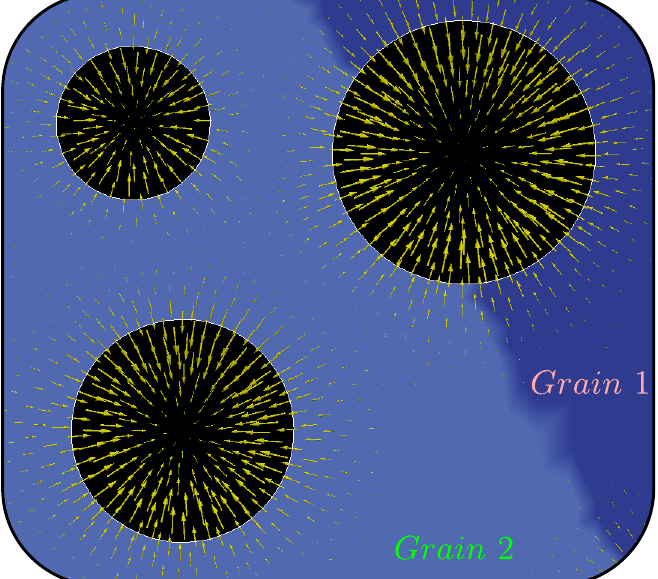
Figure 10. Smoothed precipitate interface velocity ( (cid:126) v ) for three circular precipitates (black